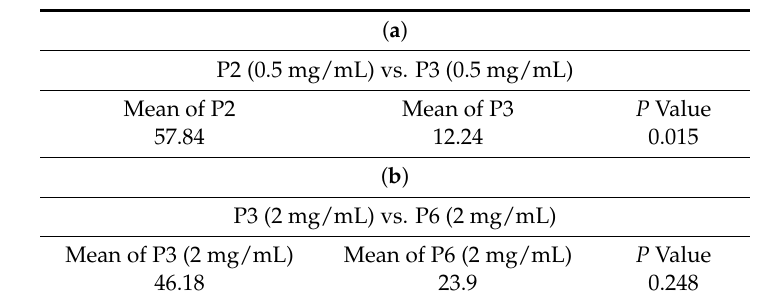
Table 3. Statistical analyses of cytotoxicity data. Mean differences of cytotoxicity effects between P2 (0.5 mg/mL) vs. P3 (0.5 mg/mL) and P3 (2 mg/mL) vs. P6 (2 mg/mL) were studied with Student’s t